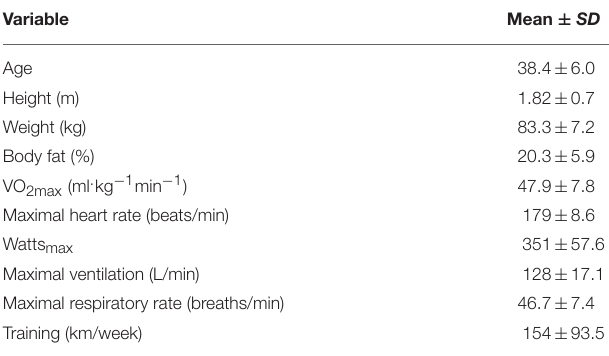
TABLE 1 | Participant characteristics ( N = 20 male